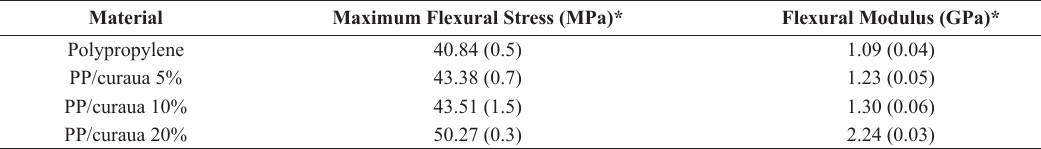
Table 3. Mechanical properties of polypropylene and the biocomposite obtained in the bending test. Material